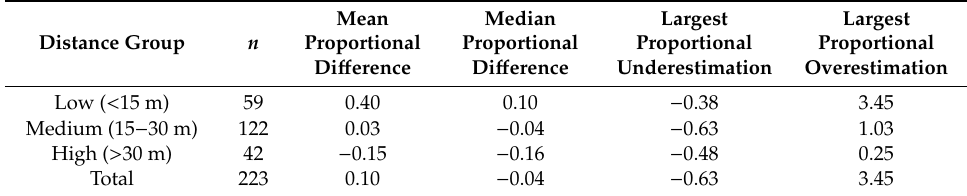
Table 2. Under- and overestimations by the UWB system for the di ff erent distance groups and the